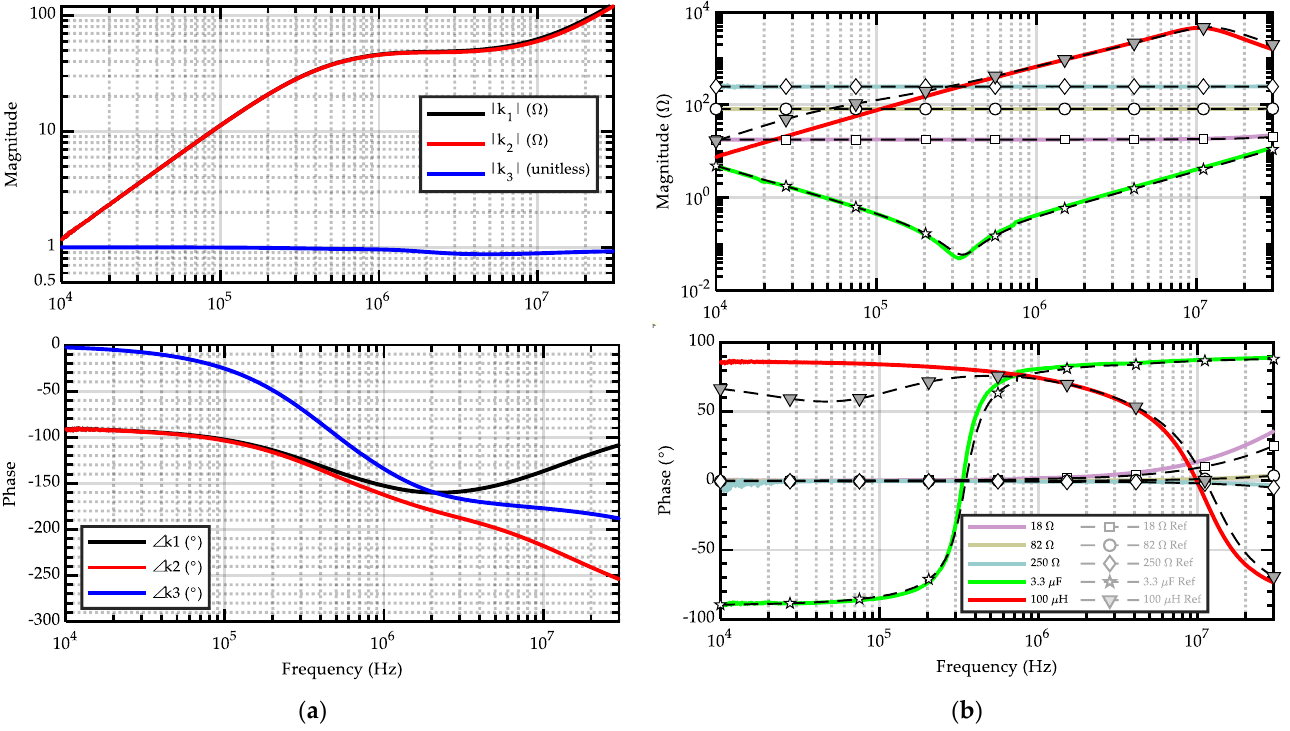
Figure 4. ( a ) Calibrated three coefficients and ( b ) verification with discrete RLC components.